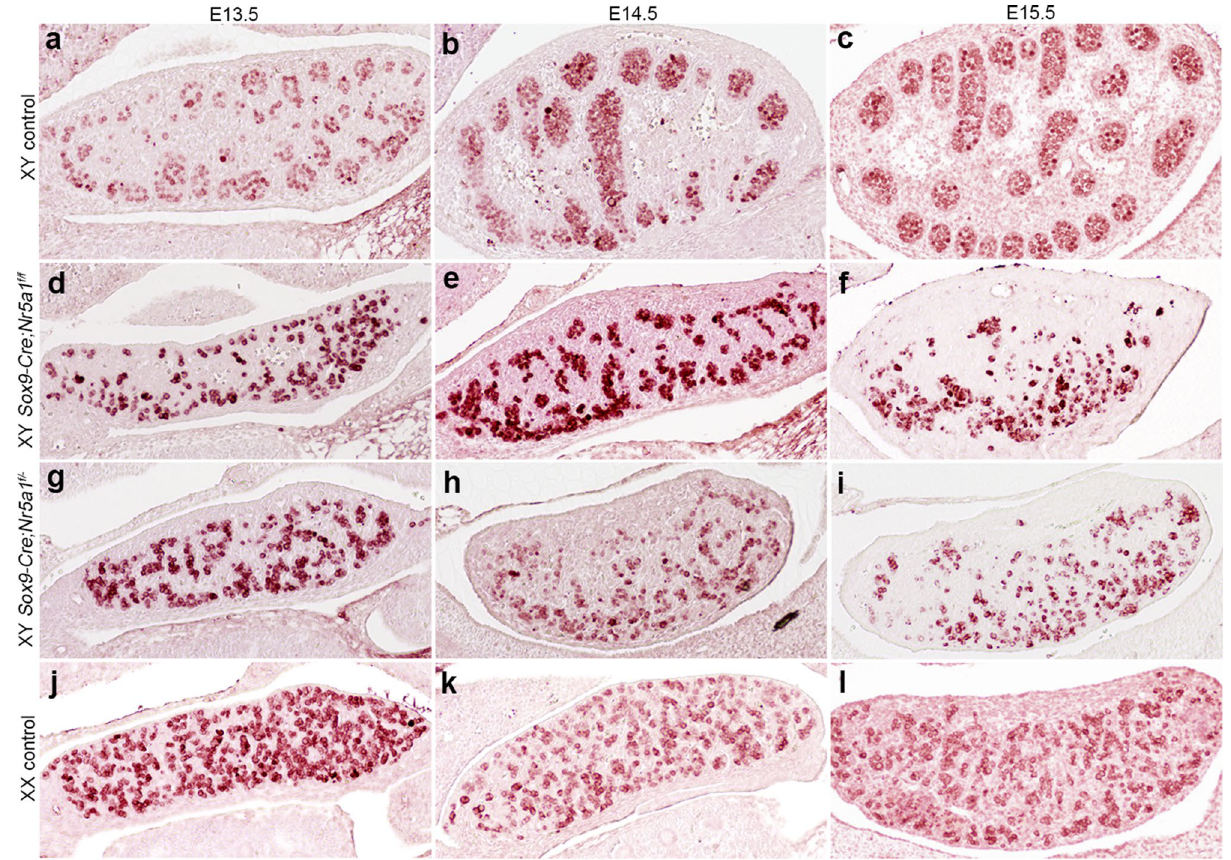
Figure 5. Distribution of germ cells in XY Sox9-Cre - Nr5a1 cKO gonads. IHC for DDX4, a germ cell marker, in gonads of XY control ( a – c ), XY Sox9-Cre;Nr5a1f. /f ( d – f ), XY Sox9-Cre;Nr5a1f. /− ( g – i ), and XX control ( j – l ) mice at E13.5, E14.5, and E15.5 (left, middle, and right panels, respectively). Ventral, anterior, and posterior sides of gonad are upwards, right, and left, respectively. Scale bar, 100 XY Sox9-Cre-Nr5a1 cKO gonads (Fig. 6c–f), but appeared less abundant than those in XX controls and tended to localise to the pole and dorsal sides. Impairment of testis cord organisation in XY Sox9‑Cre‑Nr5a1 cKO gonads. Foetal testes are mor- phologically characterised by the formation of testis cords that enclose Sertoli cells. Because the basement mem- brane of testis cords can be outlined using laminin immunostaining, we investigated testis cord formation by double staining for laminin and AMH (Fig. 7). Normal testicular cords enclosing AMH + cells were detected in XY (Fig. 7a–c) but not in XX (Fig. 7j–l) control gonads at E12.5–E14.5, as expected. The testis cords in XY Sox9- Cre;Nr5a1f. /f gonads were morphologically irregular and narrower than those in the XY controls at E12.5, and were only partially detected at E14.5 (Fig. 7d–f). The cords in XY Sox9-Cre;Nr5a1f. /− mice appeared more dis- organised than those in XY Sox9-Cre;Nr5a1f. /f gonads at E12.5 and E13.5, and the structure outlined by laminin resembled that of control XX ovaries at E14.5 (Fig. 7g–i). The testis cords in XY Nr5a1 + /− mice also appeared irregular at E12.5 and E13.5, but were indistinguishable from those of XY controls at E14.5 (Fig. 7m–o). Expression levels of Nr5a1 and gonadal genes. We compared the expression levels of genes involved in gonadal development in XY control, Sox9-Cre-Nr5a1 cKO, and Nr5a1 + /− gonads using quantitative real-time PCR (qRT-PCR) (Fig. 8). Levels of Nr5a1 in XY Sox9-Cre;Nr5a1f. /f gonads were comparable, reaching ~ 60% of those in XY control gonads at E12.5 and E13.5, respectively, whereas those in XY Sox9-Cre;Nr5a1f. /− gonads were < 50% of those in XY controls between E12.5 and E13.5. We also analysed the expression of the testis mark- ers, Sox9, Amh, desert hedgehog (Dhh) , and cytochrome P450 family 11 subfamily A member 1 (Cyp11a1, also known as P450scc) . Levels of Sox9 in XY Sox9-Cre;Nr5a1f. /f gonads were comparable to those in XY controls at E12.5, but were reduced to < 50% at E13.5; those in XY Sox9-Cre;Nr5a1f. /− gonads were < 50% at E12.5 ‒ E13.5. Moreover, levels of Amh, Dhh , and Cyp11a1 expression were significantly lower in both XY Sox9-Cre-Nr5a1 cKO models than in XY controls, and significantly lower in XY Sox9-Cre;Nr5a1f. /− than in XY Sox9-Cre;Nr5a1f. /f gonads at E12.5–E13.5. The levels of testis markers were also significantly lower in XY Nr5a1 + /− than in XY con- trol gonads at E12.5–E13.5. The ovary markers Foxl2 and follistatin (Fst) were similarly expressed in all groups at